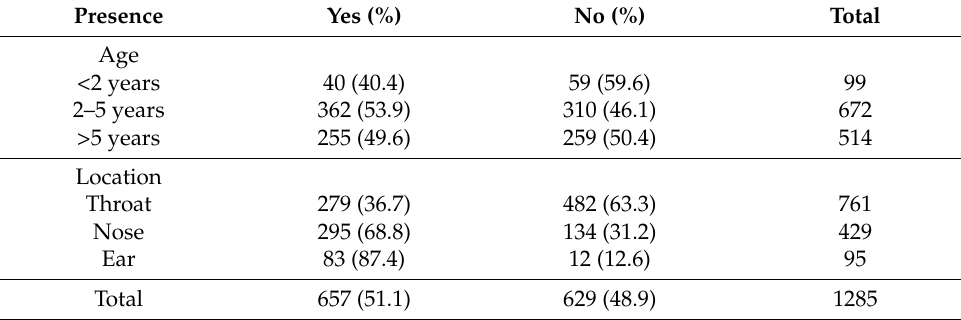
Table 4. Presence of foreign bodies in the age groups and